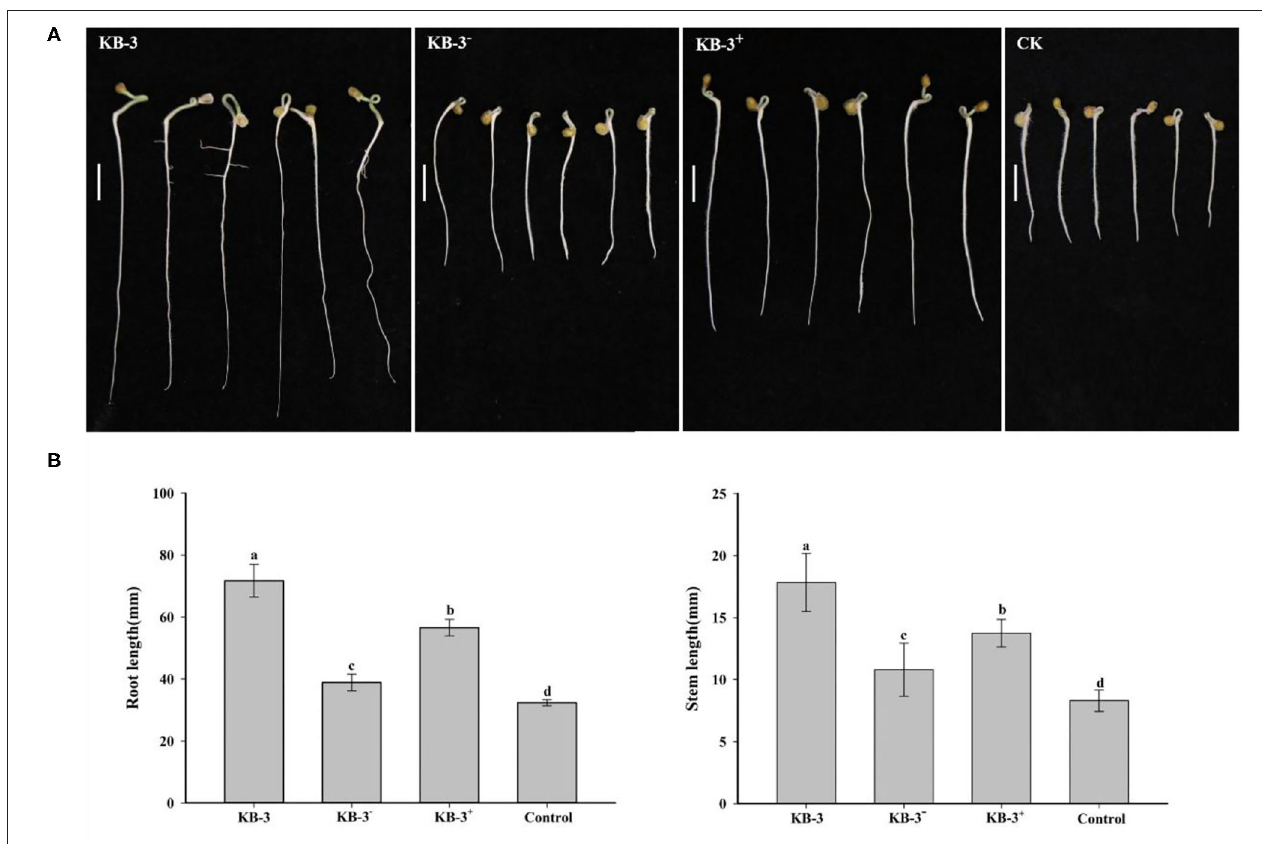
FIGURE 6 | Growth-promoting assays for tomato treated with sterile filtrated Luria-Bertani (LB) containing 10 mg/ml L-tryptophan cultural broth of wild strain KB-3 of Fusarium oxysporum (KB-3), cured strain KB-3 (KB-3 − ), restored strain KB-3 (KB-3 + ) and LB broth containing 10 mg/ml L-tryptophan (control) after 5 days. (A) The growth situation of tomato seedlings under different treatments. Bars = 10mm. (B) The means ( n = 30) root (left) and stem (right) lengths of tomato seedlings. The interval bars represented the standard deviation of the means. Different letters marked on the top of columns were significantly different according to Duncan’s multiple range test at p <